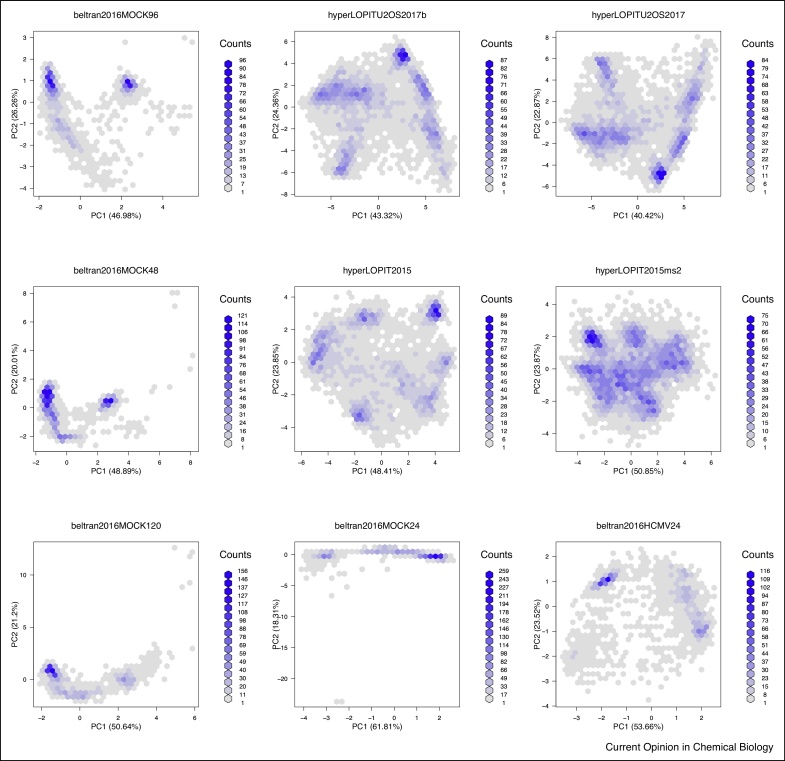
Density PCA plots for the 29 experiments used in this study. PC 1 and 2 were used except for itzhak2016stcSILAC, where PC 1 and 3 were used to conform to the original authors figures. The experiments are ordered according to the median average between cluster distance (see Figure 8). Figures have been generated using the plot2D function from the pRoloc package.